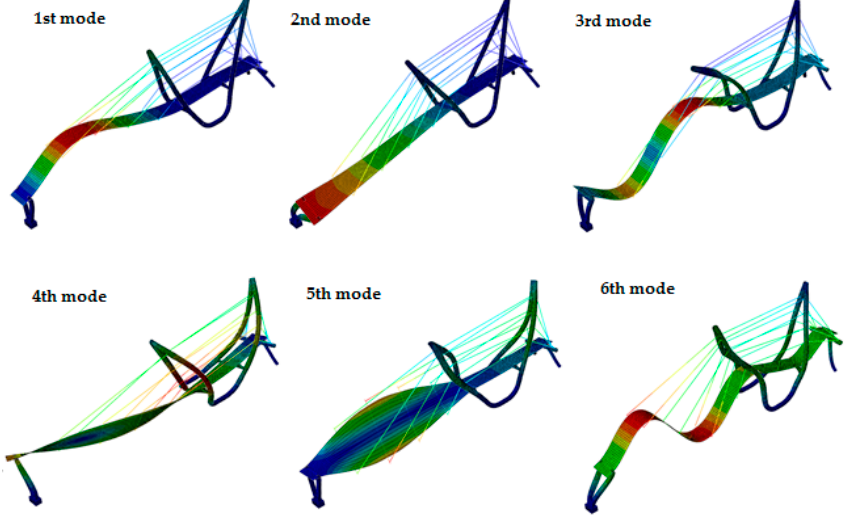
Figure 8. The mode shapes of the cable-stayed footbridge with the GFRP slab.